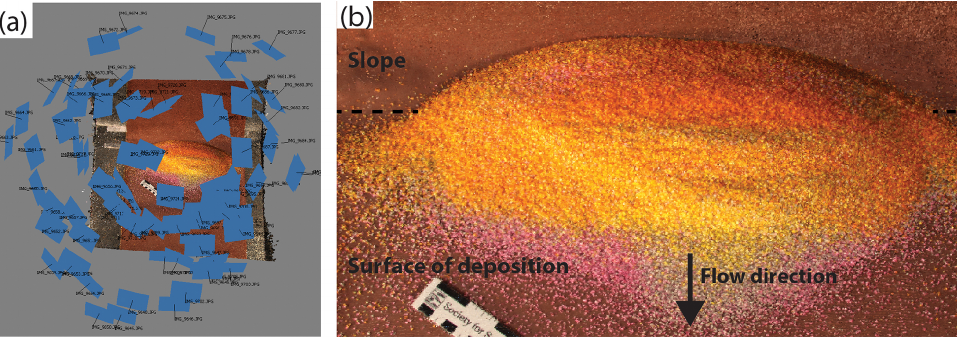
Figure 4. (a) View of the different position of the camera to take pictures for structure-from-motion photogrammetry; (b) 3-D model obtained with structure from motion. Three colored sands were used for this experiment (yellow, grey,